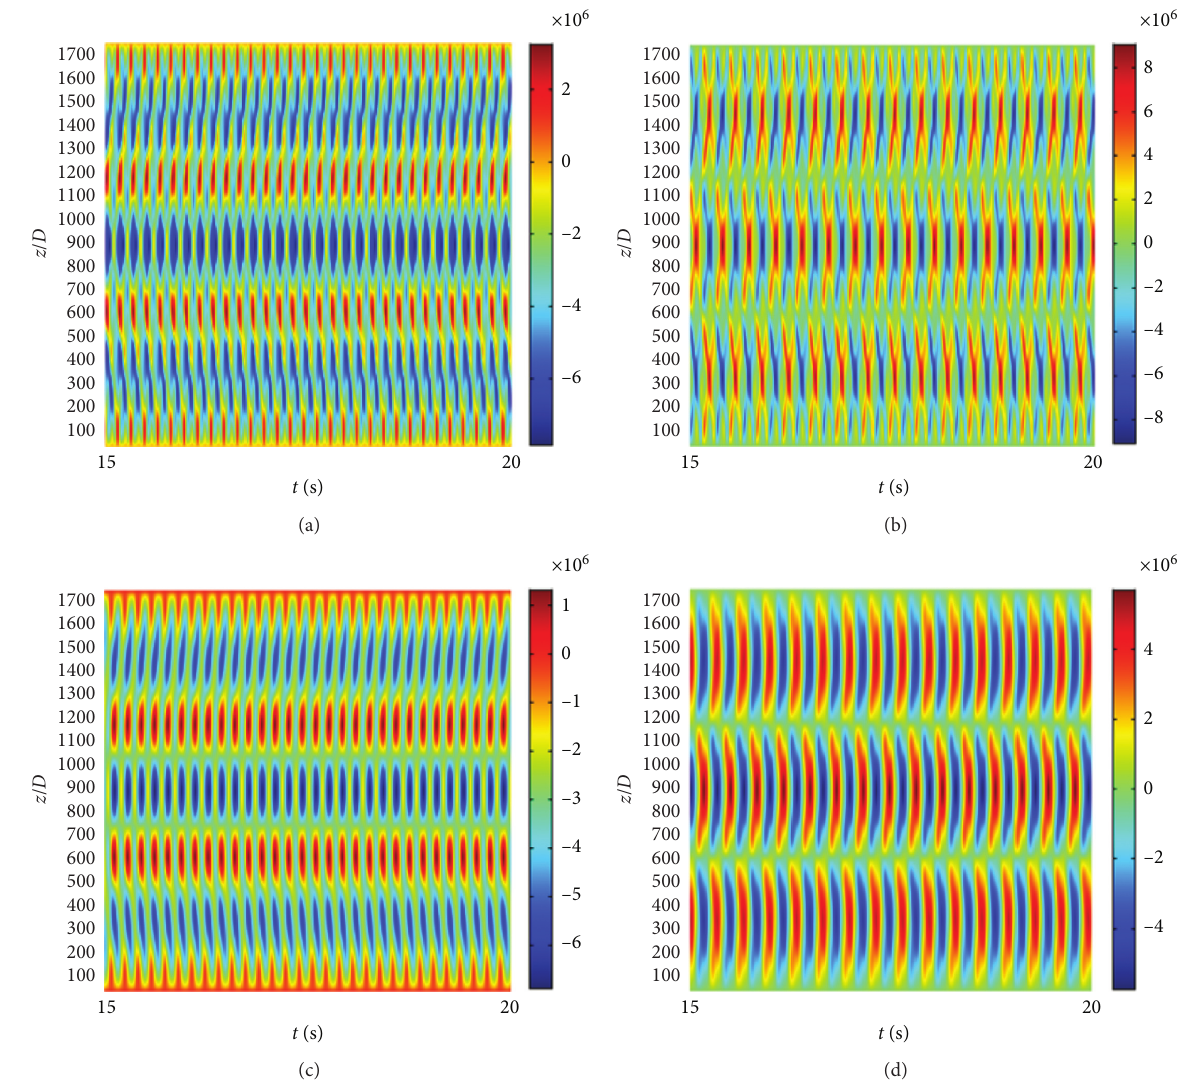
Figure 9: Space-time response of stress under different viscoelastic coefficients. (a) The in-line and (b) cross-flow with a � 0.001. (c) The in- line and (d) cross-flow with a �